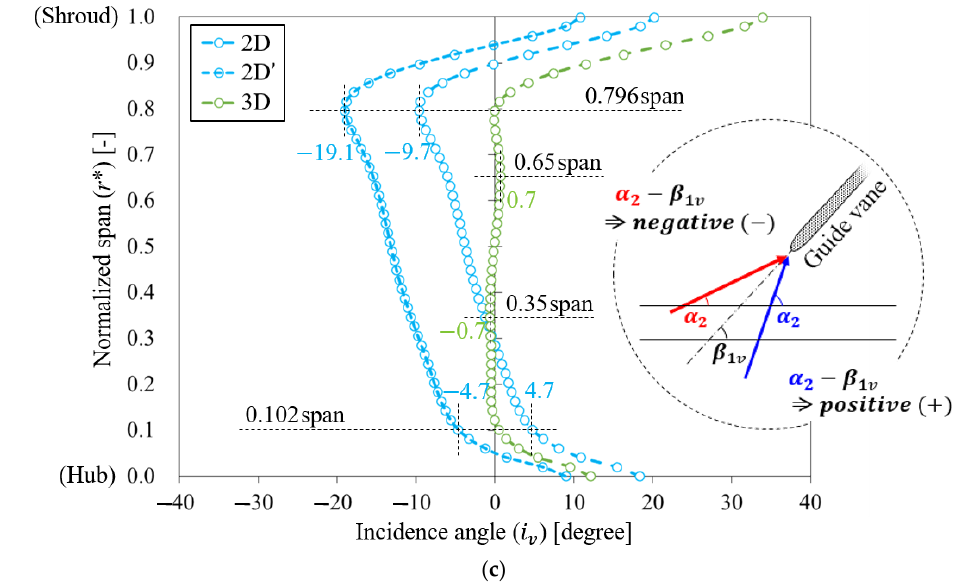
Figure 4. Selection for inlet vane angle (1.0 Φ d ): ( a ) schematic drawing of velocity triangle at the blade outlet; ( b ) absolute flow angle distribution over the entire span; ( c ) incidence angle distribution over the entire span.